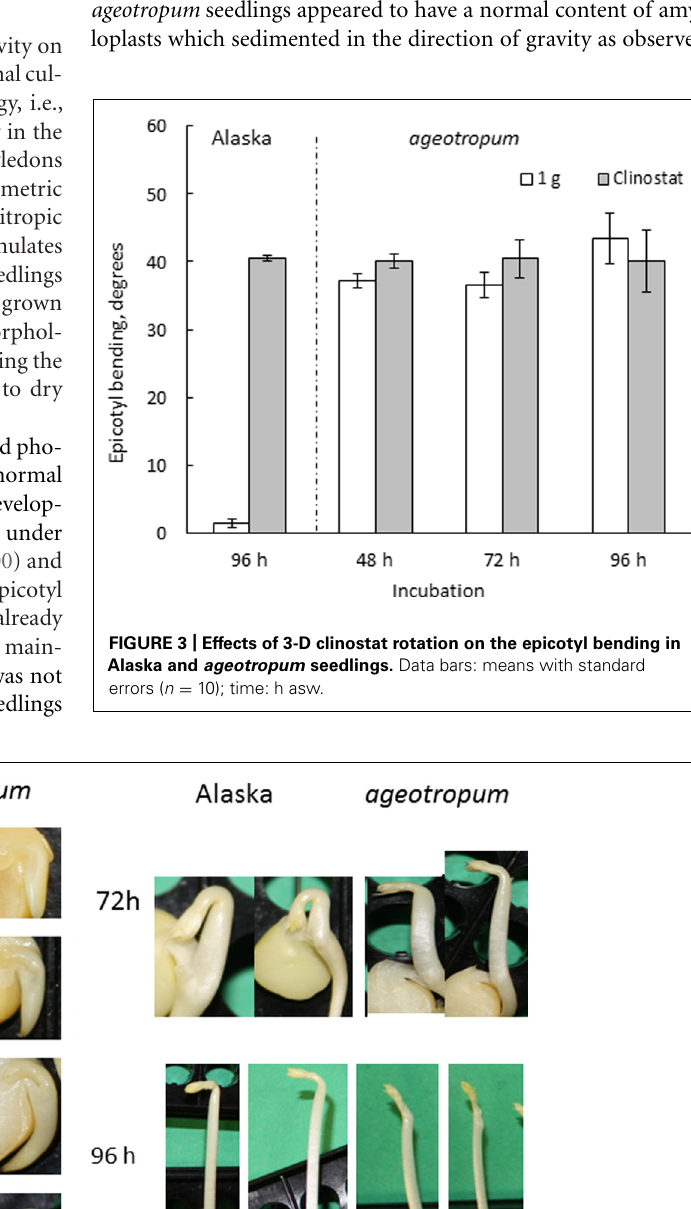
FIGURE 2 | Kinetics of the apical hook development in Alaska and ageotropum pea seedlings grown under 1- g conditions. Photographs were taken at the time points shown in h asw. To show the inside, the cotyledon at the front side was removed prior to photographing. Photos at 0 h* show seeds imbibed in water in a refrigerator for 1 h to